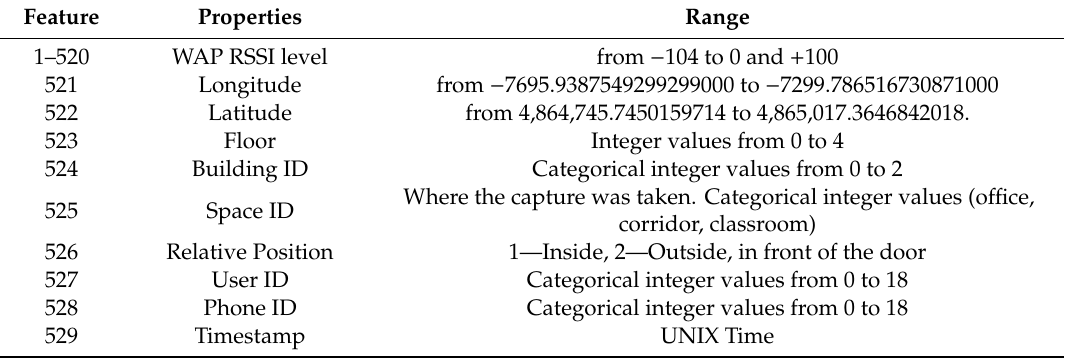
Figure 2. Hierarchical fusion algorithm.